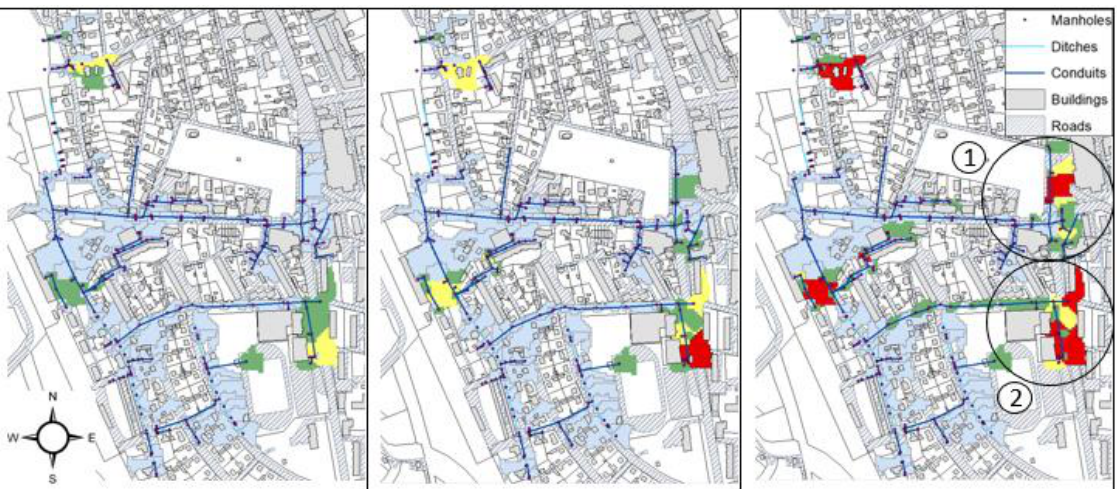
Figure 7. Visual presentation of the EWL in Haapsalu for scenarios 1, 2 and 3. The colors indicate the risk levels: green indicates low risk, (i.e., risk level 1) yellow indicates moderate risk (i.e., level 2) and red indicates severe flooding risk (i.e., level 3); light blue indicates no risk.